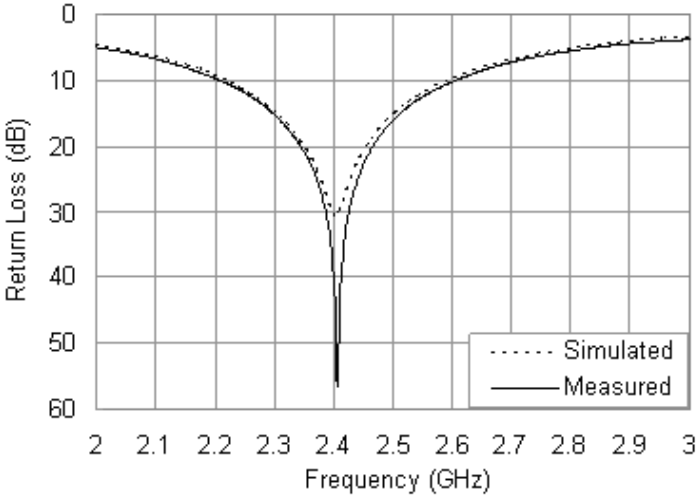
Figure 7. Measured and simulated return loss